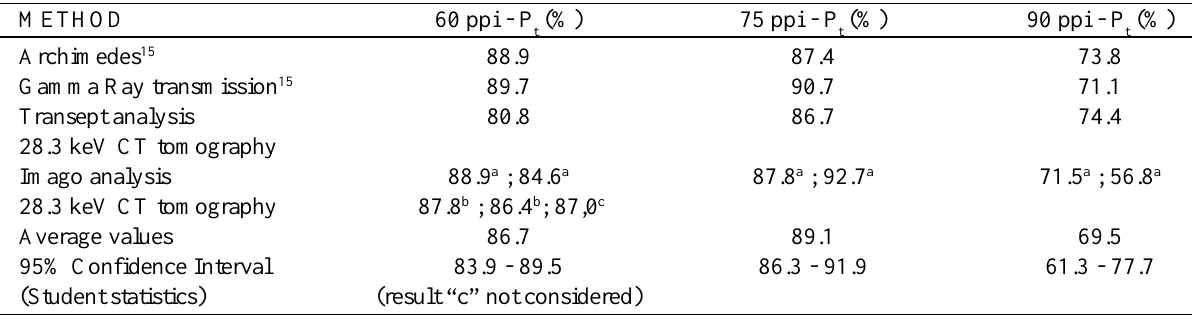
Table 1. Total Porosity (P